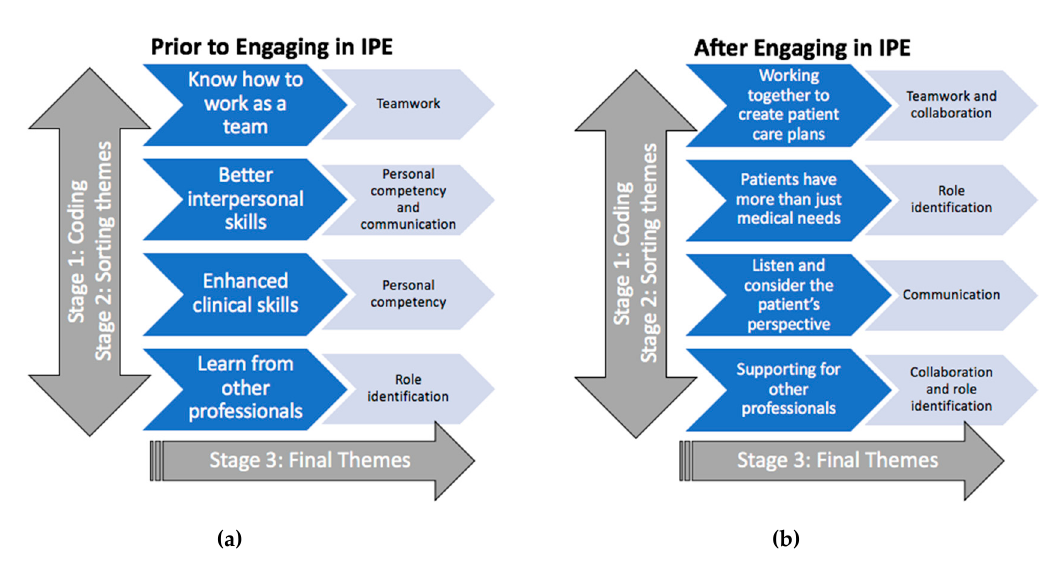
Figure 1. Results of thematic synthesis from open-ended questions: ( a ) prevailing themes from students’ responses prior to engaging in IPE; ( b ) prevailing themes from students’ responses after engaging in IPE.